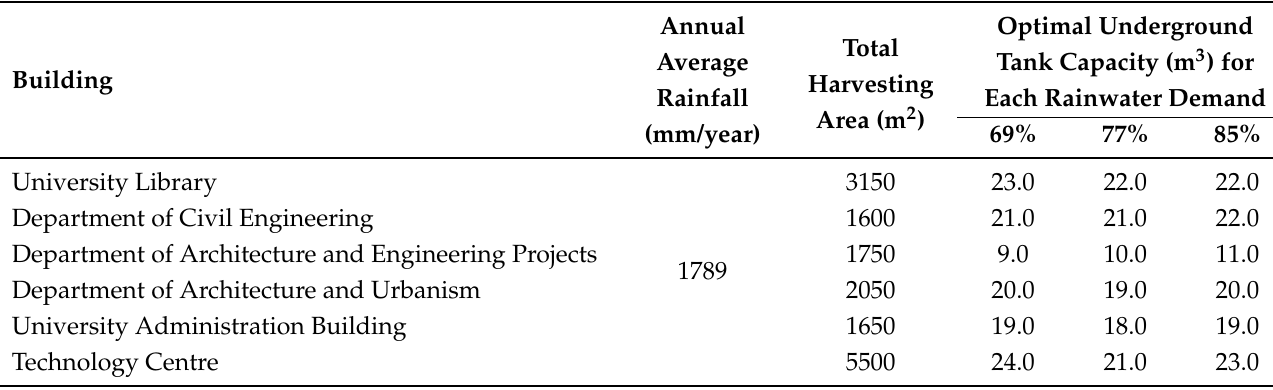
Table 5. Optimal underground tank capacity, rainfall and harvesting area for